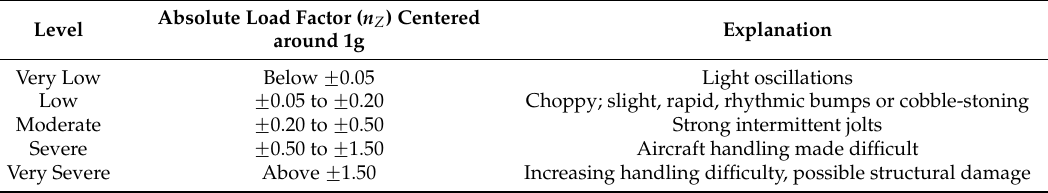
Table 2. International Civil Aviation Organization’s (ICAO’s) definitions of turbulence levels.